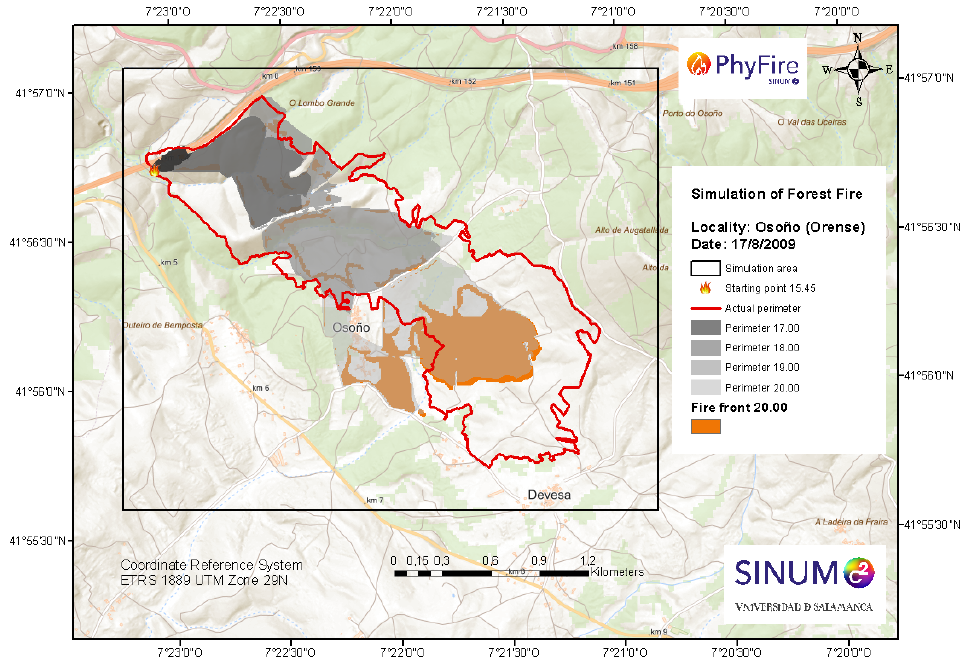
Figure 4. Simulation area (black rectangle), fire ignition point, actual final perimeter (red line), simulated burned areas each hour, and fire front at 20.00. No firefighting actions were